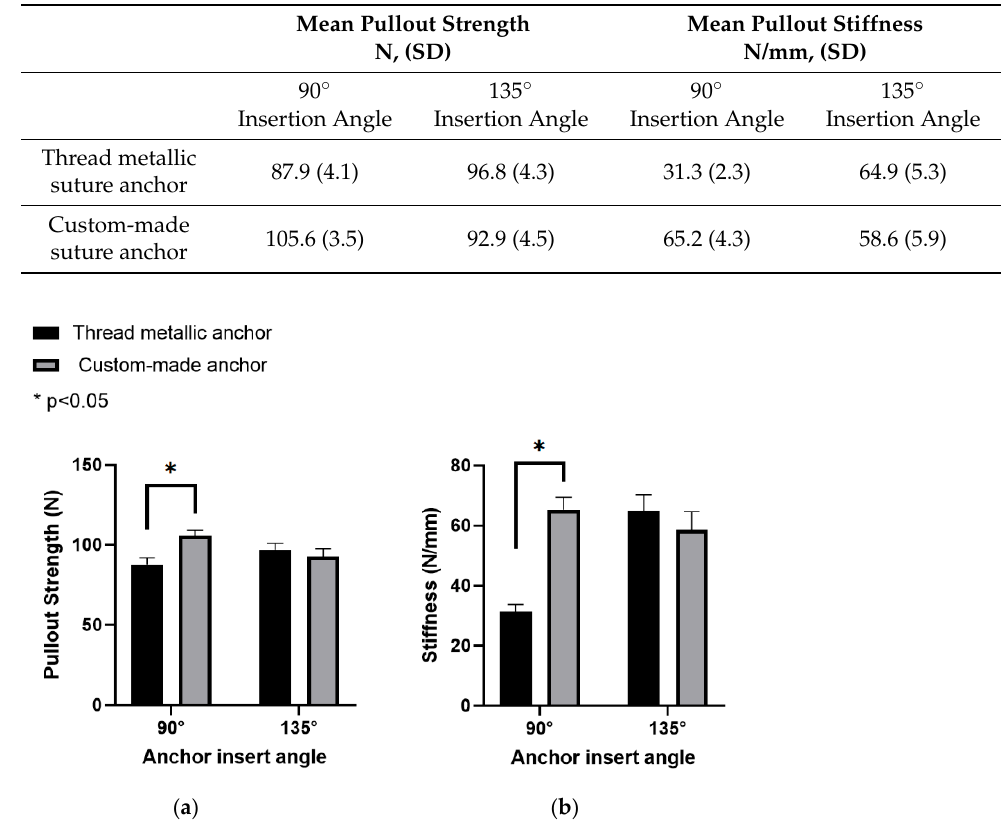
Table 1. Mean pullout strength and stiffness for each group.